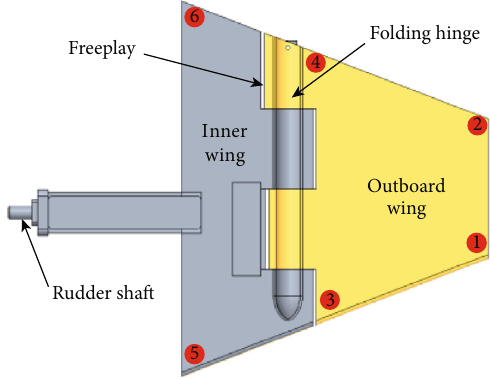
Figure 1: Sketch of the experimental folding fi n.